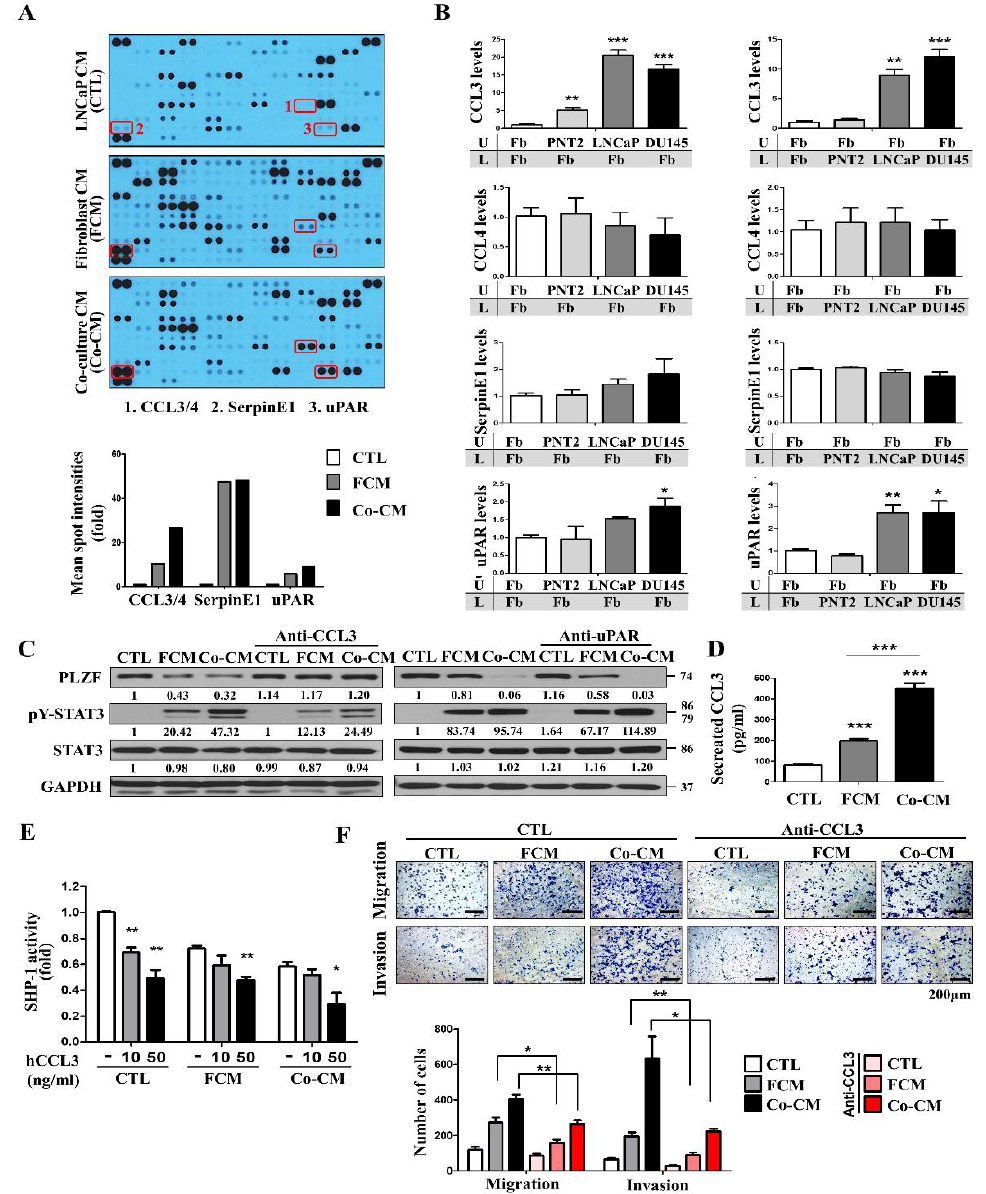
Figure 6. Loss of CCL3 inhibits the fibroblast-induced prostate cancer cells migration and invasion. ( A ) Each CM was applied to the cytokine arrays (top). The cytokines in boxes are more enriched in co-cultured CM than in fibroblast CM. Mean intensities of cytokines are plotted (bottom). ( B ) PNT2, LNCaP, and DU145 cells were co-cultured with fibroblast in a cell culture chamber for 24 h. Cells in a lower chamber were lysed for qRT-PCR. ( C ) LNCaP cells were treated with the indicated conditioned media with the addition of an anti-CCL3 antibody or anti-uPAR antibody and then subjected to Western blotting. ( D ) Concentrations of CCL3 in the indicated conditioned media were analyzed using an ELISA kit. Summarized results from three independent experiments were quantified as the mean ± SD. ( E ) Cells, which had been transfected with the luciferase plasmid, were pre-treated with recombinant protein CCL3 for 4 h, incubated under FCM or Co-CM for 24 h. ( F ) LNCaP cells, which had been pre-treated with anti-CCL3 antibody for 4 h, were incubated in the indicated CMs for 24 h. The relative cell numbers are shown (right). In B, D, E, and F, representative images from three independent experiments were quantified as the mean ± SD; * p < 0.05, ** p < 0.01, *** p < 0.001. The uncropped blots and molecular weight markers of Figure 6 are shown in Figure S10